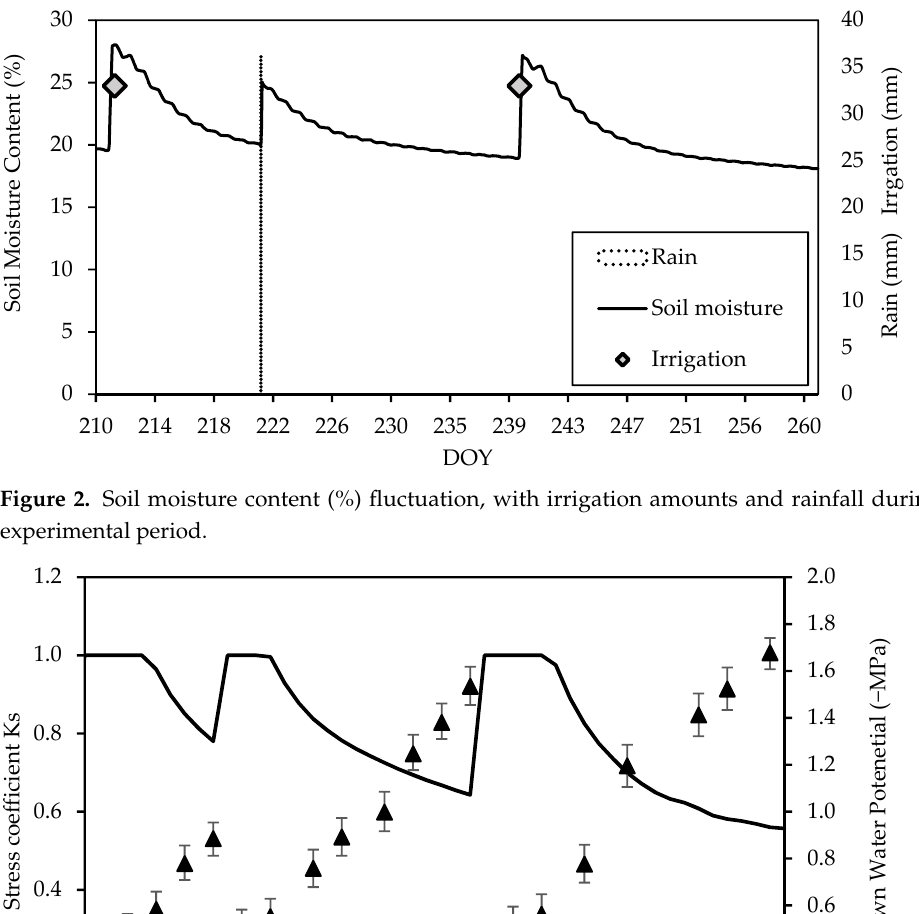
experimental period.